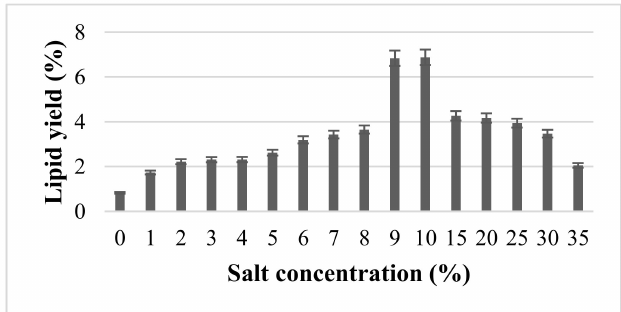
Figure 2. The e ff ect of di ff erent NaCl salt concentrations on the extracted lipid using microwave-assisted extraction (MAE) at 10% ( w / v ) solid loading, 100 ◦ C and 5